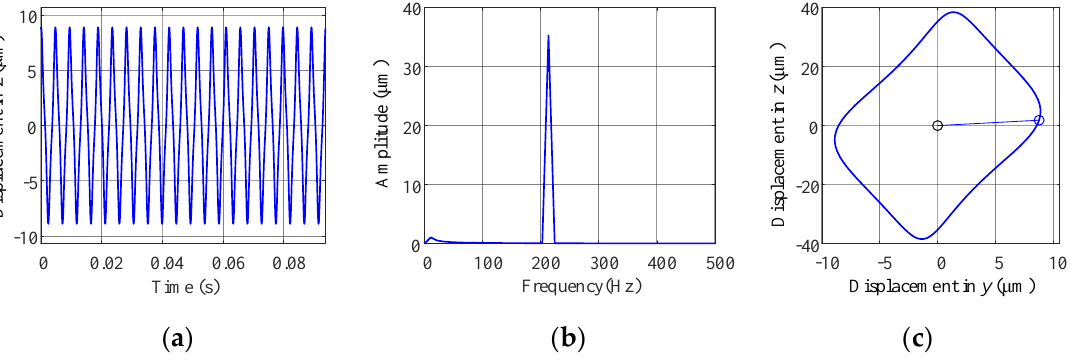
( c ) Figure 13. Vibration response under speed of r n = 12,800 r/min and unbalanced mass of m e = 4 × 10 − 5 kg·m. ( a ) time domain response; ( b ) frequency domain response ; ( c ) displacement. It can be seen from Figure 13 that under the conditions of high speed and small unbalance, the amplitude is only about 0.3 μm, the time domain and frequency domain components are simple, the vibration is stable, and the orbit is a regular circle. By introducing SFD, in the high speed, after increasing the unbalance, the rotor vibration becomes more stable, which improves the stability of the rotor. After reducing the unbalance, the vibration response amplitude can be significantly decreased. Through qualitative comparative analysis with the relevant experiment results of the SFD-rotor system in Refs. [14,26], the stability of the SFD-rotor system can be improved by appropriately increasing the unbalance. This is essentially consistent with the simulation results in this paper, which verifies the correctness of the simulation model and analysis results. In subsequent research, we will use the to-be-built test rig to further carry out the experiments about vibration and stability of the SFD-rotor system. 5. Conclusions